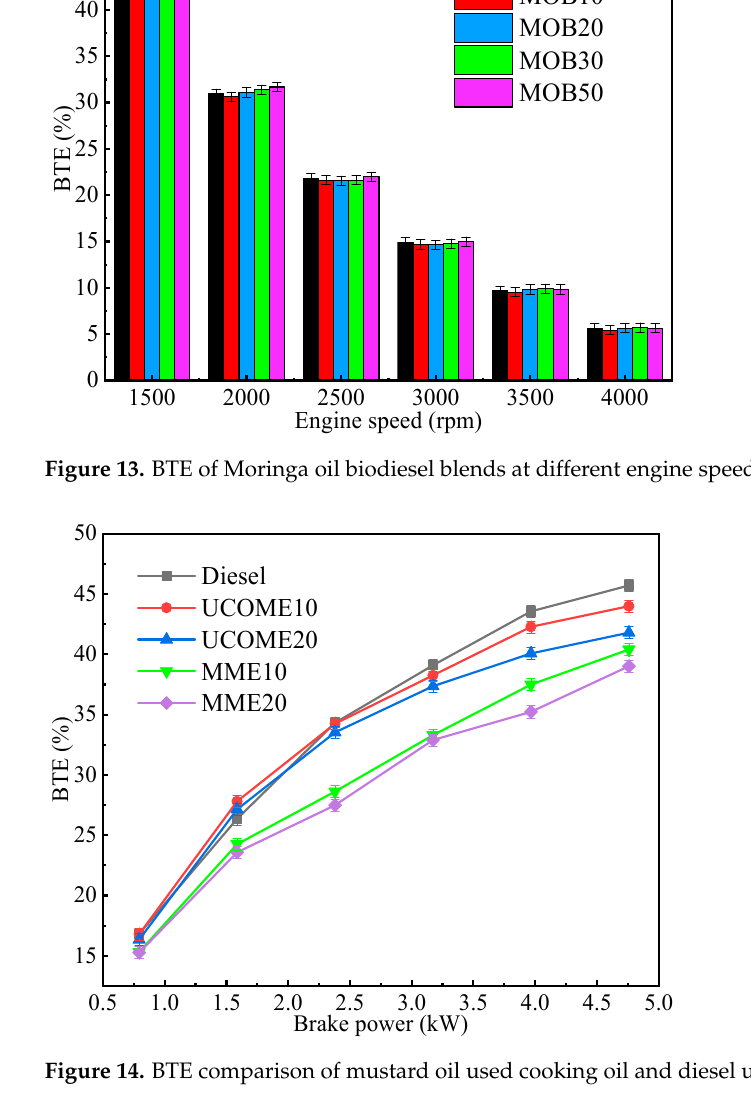
Figure 13. BTE of Moringa oil biodiesel blends at different engine speeds [172].